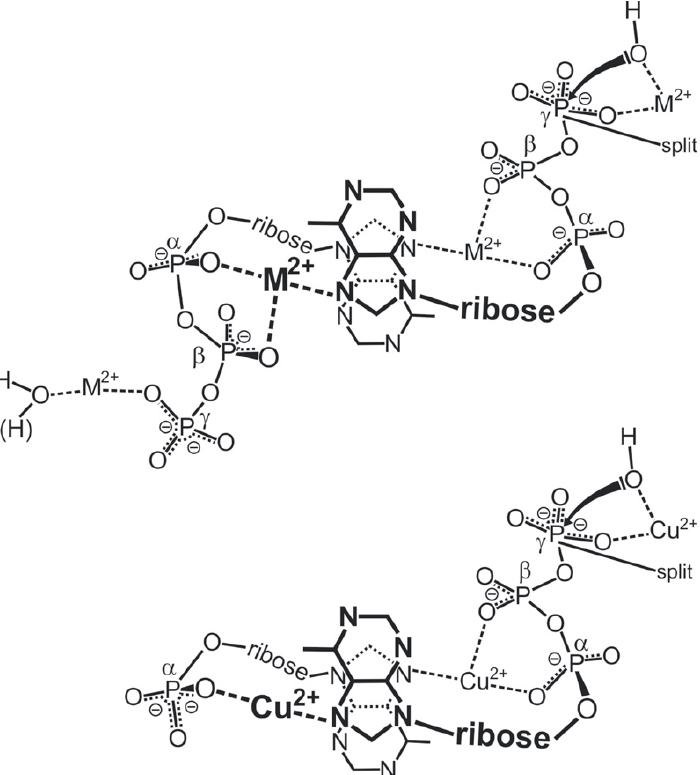
Figure 10. TOP: Proposed structure of the reactive [M 2 (ATP)] 2 (OH) − dimer, which occurs in low concentration during the metal ion-promoted dephosphorylation of ATP. The intramolecular attack of OH − is indicated on the right-hand side, while the left-hand side is ready to transfer also into the reactive state by deprotonation of the coordinated water molecule or to undergo an intramolecular water attack, corresponding to the dimeric [M 2 (ATP)] 2 species. BOTTOM: Probable structure of the reactive Cu 3 (ATP)(AMP)(OH) − species. The intramolecular attack of OH − is indicated on the right-hand side, while the left-hand side shows the metal ion bridge stabilizing the purine stack by M 2+ coordination to the phosphate group of AMP 2 − and to N7 of ATP 4 − [14,80,94]. The structures are adapted from Ref [80].